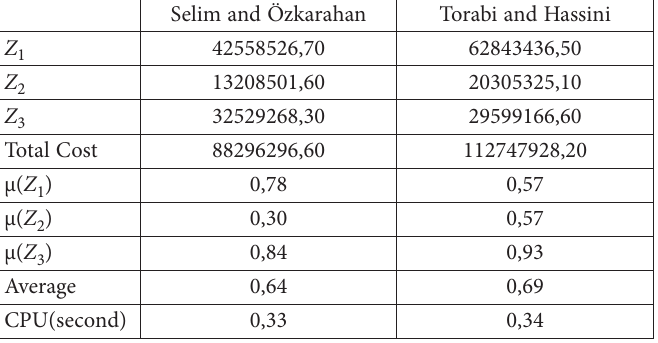
Table 6. Comparison of the results for different approaches when l = 0.4 Selim and Özkarahan Torabi and